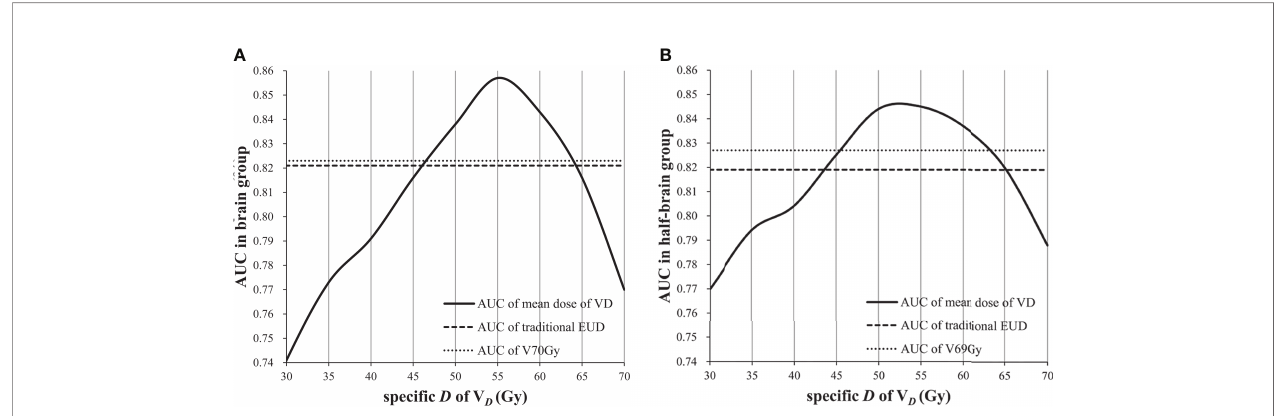
FIGURE 3 | AUC of mean dose of V D as D changed: (A) AUC in brain group; (B) AUC in half-brain